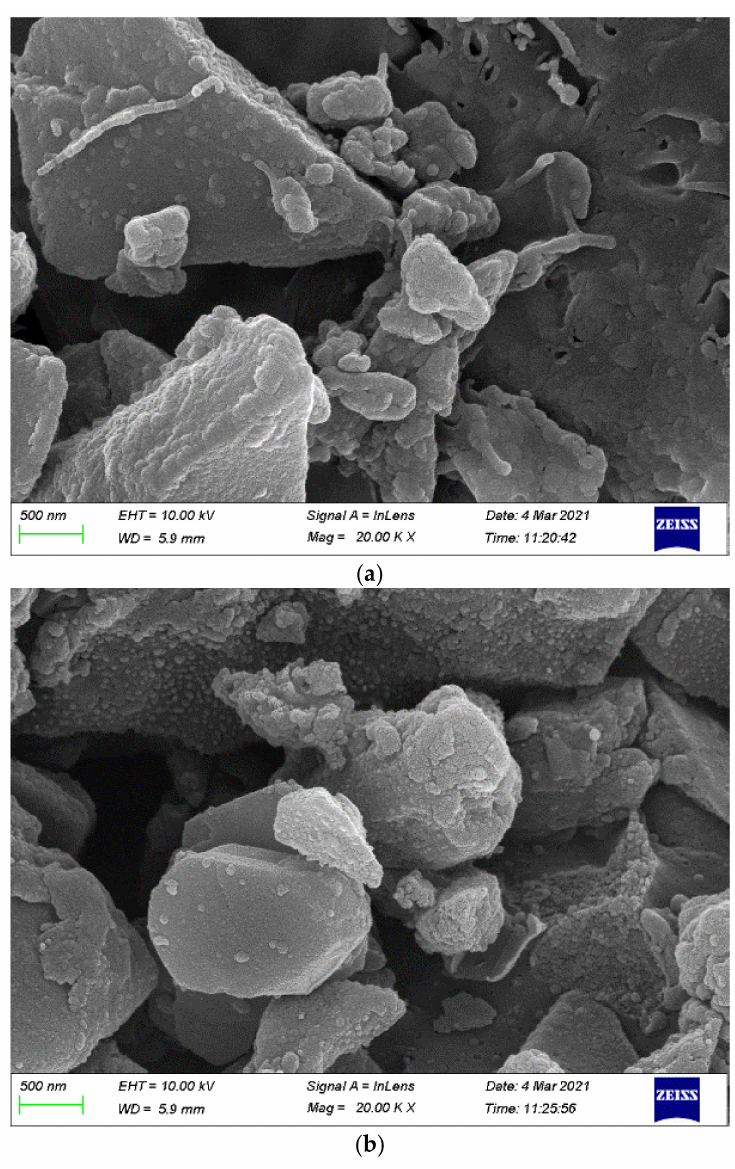
Figure 10. SEM images of 3% K 2 CO 3 -modified activated coke before and after adsorption of SO 2 and NO. ( a ) Before adsorption, ( b ) After